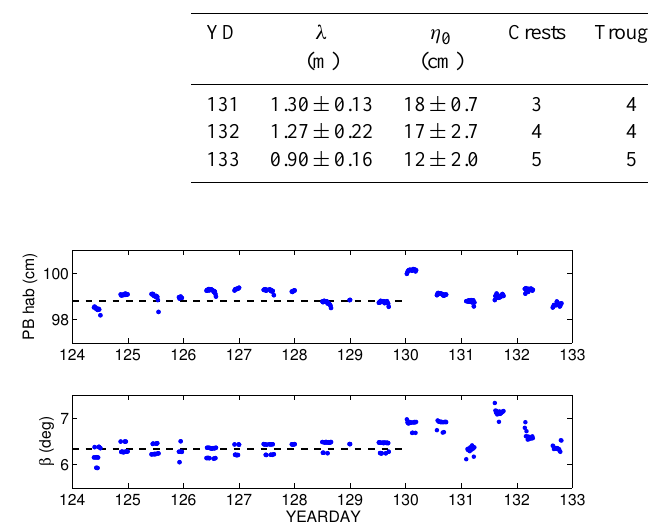
Figure 16. Cartoon illustrating the sequence leading to the surficial fine-grained sediment layer via the development of vortex ripples. Cobbles and stones are black, finer sediments brown. (a) Initial state at low water. (b) Rising tide, larger particles displaced / dislodged by the shorebreak and swash. (c) Rising tide after passage of the shorebreak and swash, finer sediments have been gathered into rip- ple crests, leaving a stone and cobble lag in the troughs. (d) Falling tide, ripples planed flat by swash and shorebreak, creating a veneer of fine sediment. (e) Final state at low water.